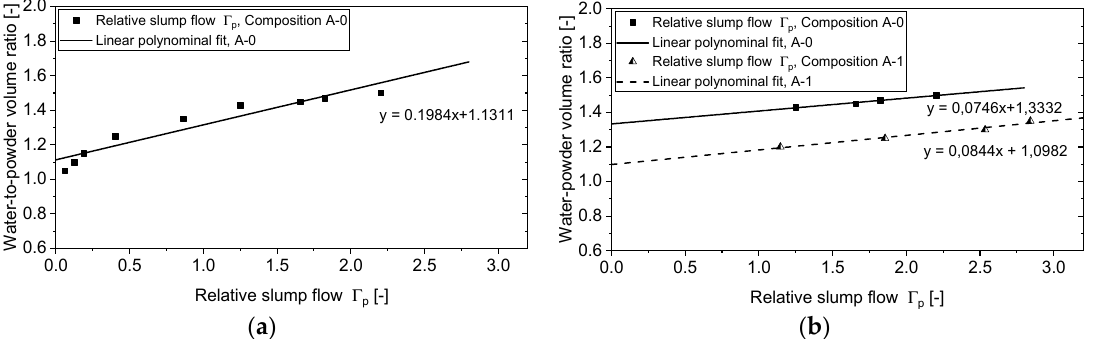
Figure 7. Results of relative slump values for the binder pastes: ( a ) all values for the composition A-0, and ( b ) results obtained in the range Γ p >1 for the compositions A-0 and A-1.